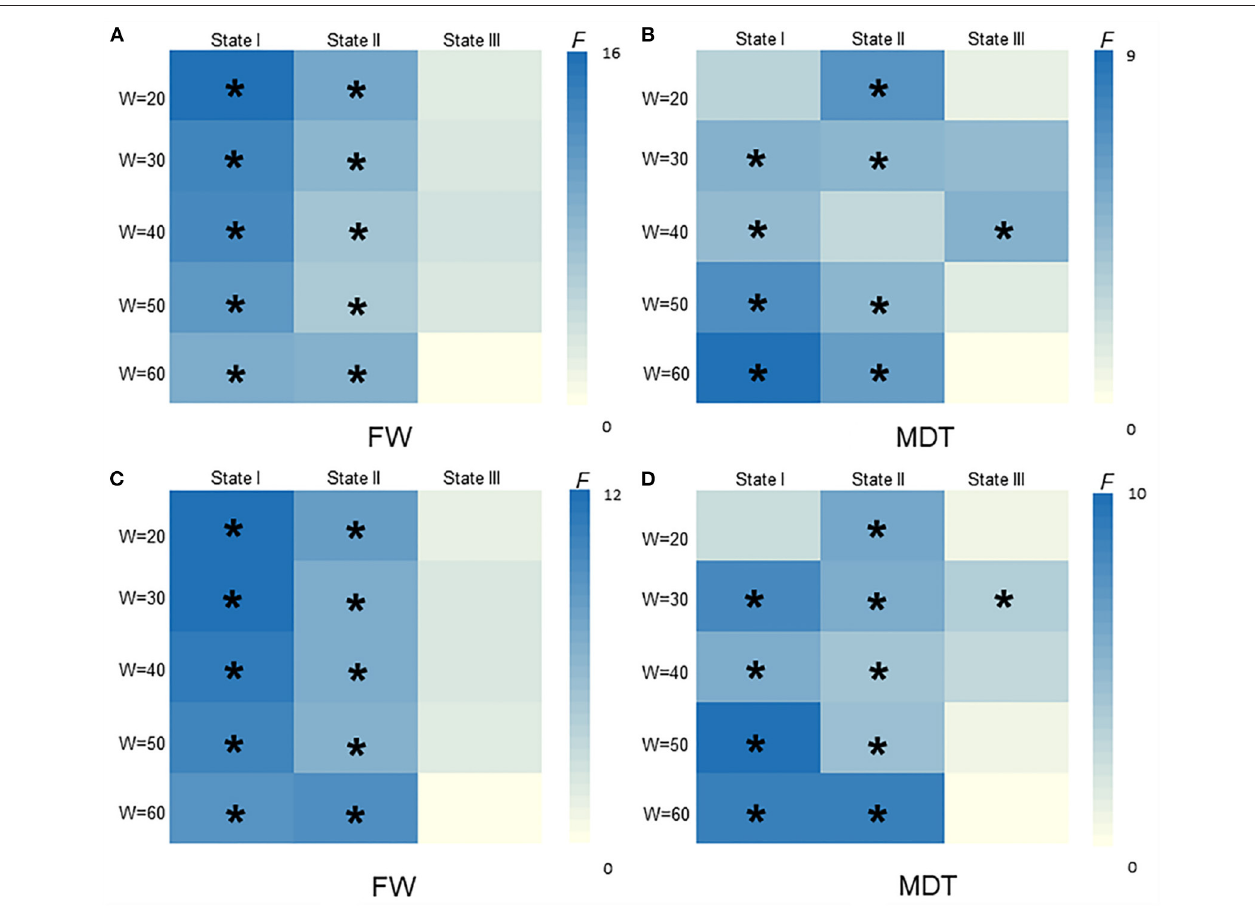
FIGURE 5 | The difference of FW and MDT in different widths of window size among HCs, CSVD-CU, SVCI (20TRs, 30TRs, 40TRs, 50TRs, 60TRs). (A) Comparison of FW between HCs and CSVD by GLM. (B) Comparison of MDT between HCs and CSVD by GLM. (C) Comparison of FW among HCs, CSVD-CU and SVCI by GLM. (D) Comparison of MDT among HCs, CSVD-CU and SVCI by GLM. GLM, general linear model; FW, fractional windows; MDT, mean dwell time. * P <